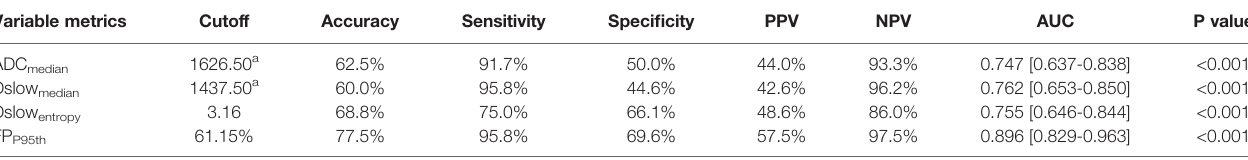
TABLE 5 | The diagnostic performance of the independent in fl uencing factors for the intestinal/mixed vs. diffuse-type GC. Variable